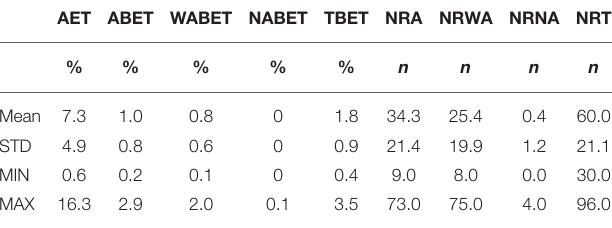
Frontiers in Cellular and Infection Microbiology |